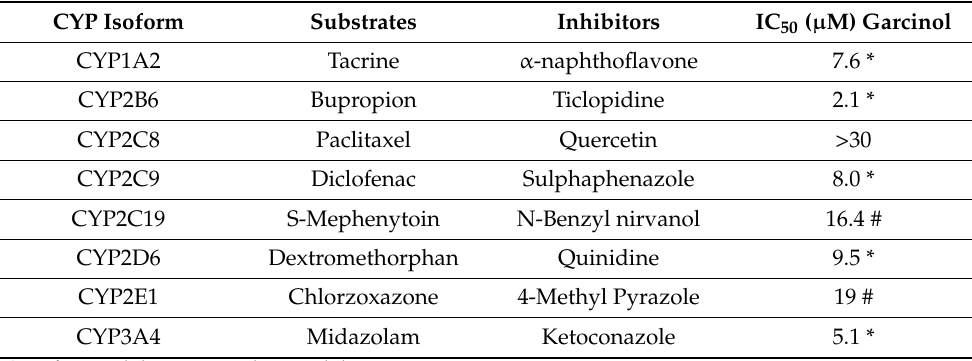
Figure 1. IC 50 curves of garcinol for CYP450 activities using the cocktail substrate including CYP1A2 for tacrine 1-hydroxylase, CYP2B6 for bupropion hydroxylase, CYP2C8 for paclitaxel 6-hydroxylase, CYP2C9 for diclofenac 4-hydroxylase, CYP2C19 for S-mephenytoin 4-hydroxylase, CYP2D6 for dextromethorphan O-demethylase, CYP2E1 for chlorzoxazone 6-hydroxylase and CYP3A4 for mida- zolam 1 (cid:48) -hydroxylase. Table 2. Inhibition parameters of garcinol towards eight CYPs in rat liver